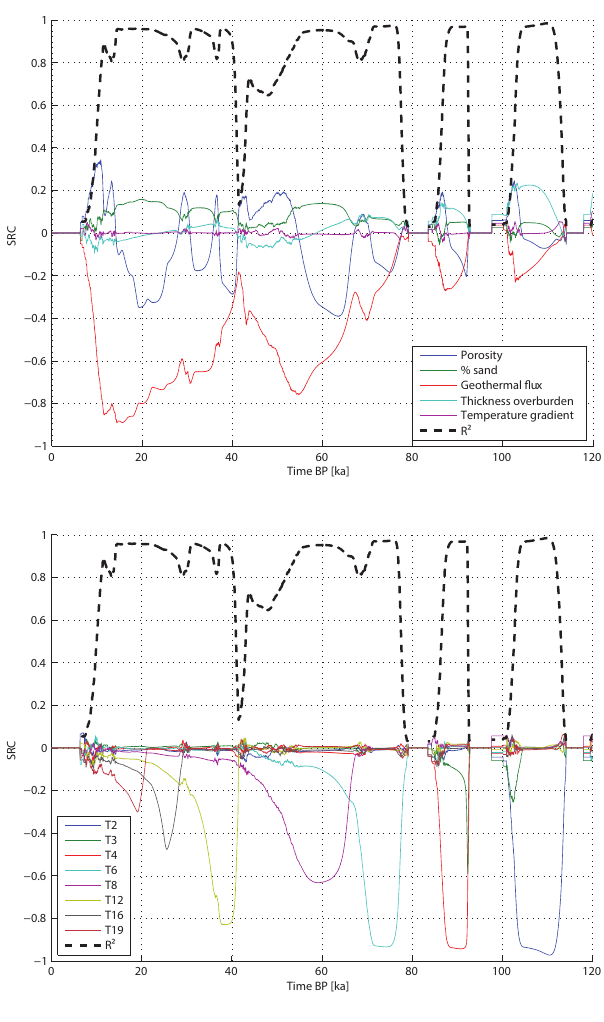
Figure 9. SRCs as a function of time for a global sensitivity study of permafrost progradation during a Weichselian glaciation (top: phys- ical parameters, bottom: selected set of temperature parameters T1 to T26, which are variables that are used to control the magnitude of the various temperature plateaus during the Weichselian temper- ature